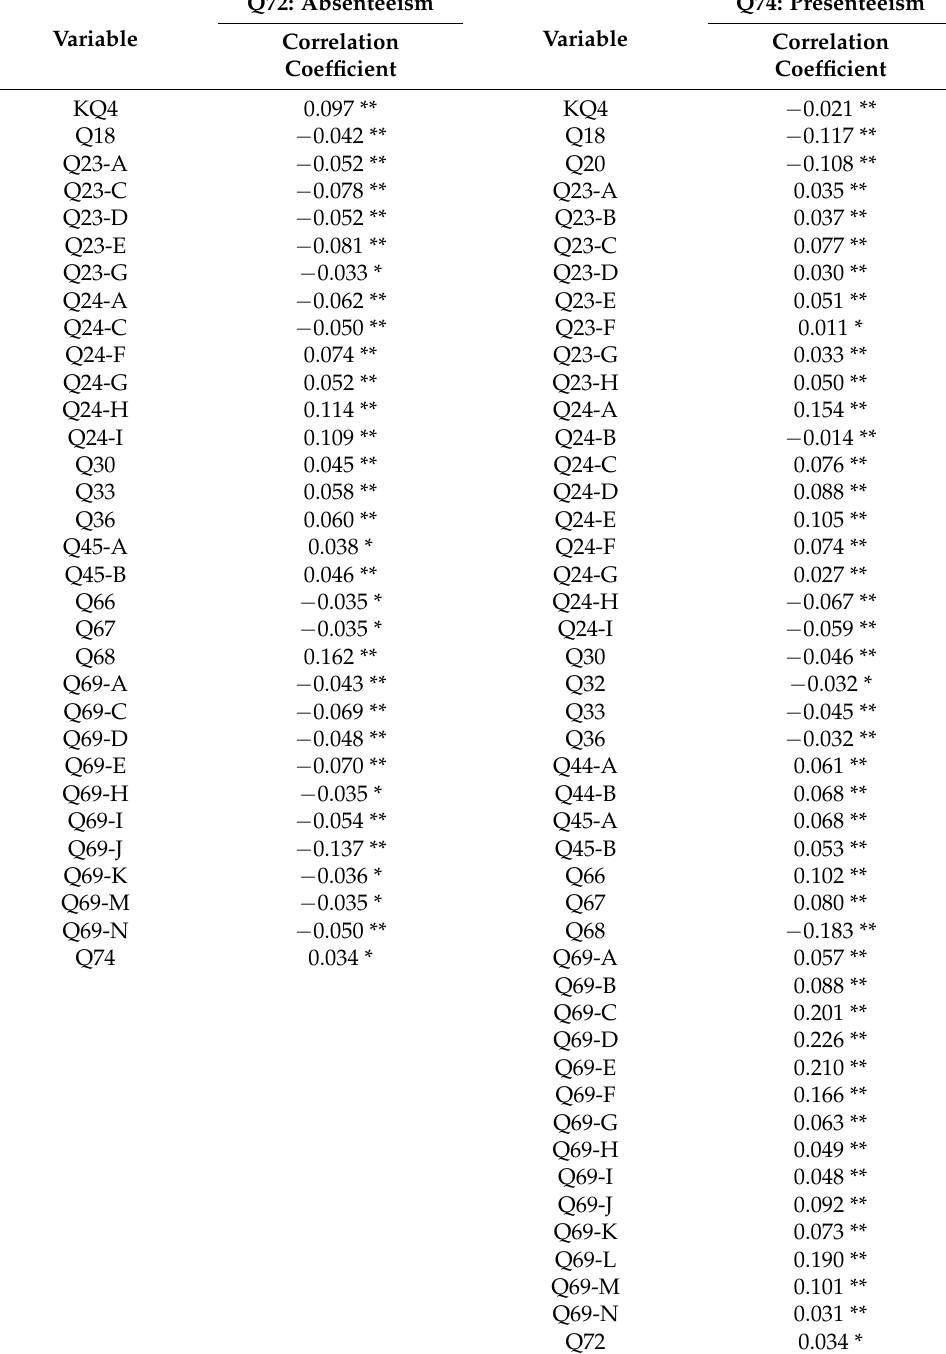
Table 2. Variables significantly correlated with absenteeism and